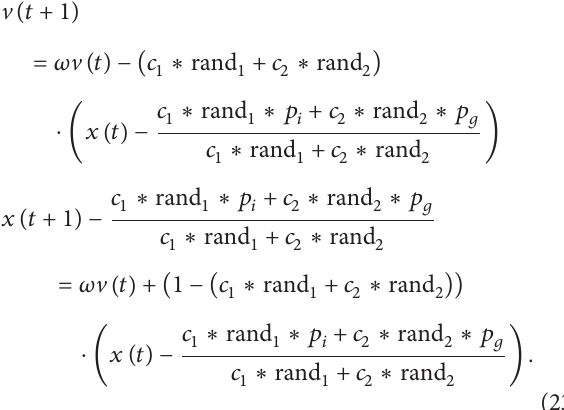
Figure 1: The results of nonlinear function needing to be optimized versus Times